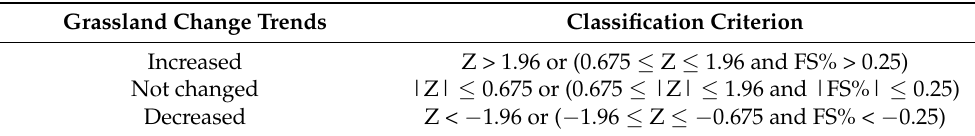
Table 1. Classes and the criteria of grassland change